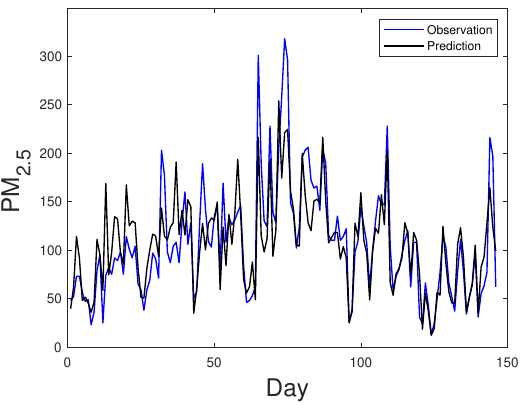
Figure 5. Plot of observed versus predicted PM 2.5 levels for Student-t PVCM (Santiago data).